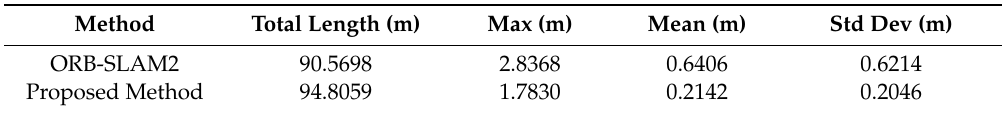
0.000.501.001.502.00 Figure 17. Position error of deep learning position network (PoseNet) in closed round hall. 1815222936435057647178859299106113120127134141148155162169176183190 P o s i t i o n e rr o r ( m ) Frame ID